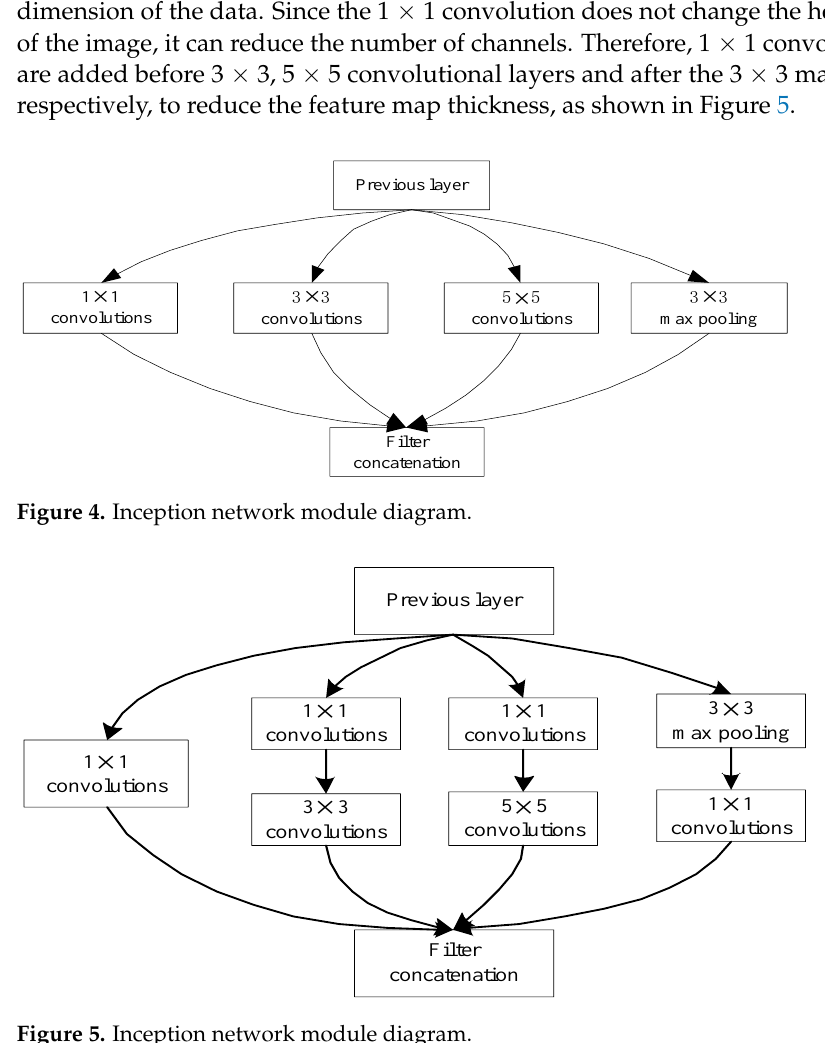
Figure 5. Inception network module diagram.